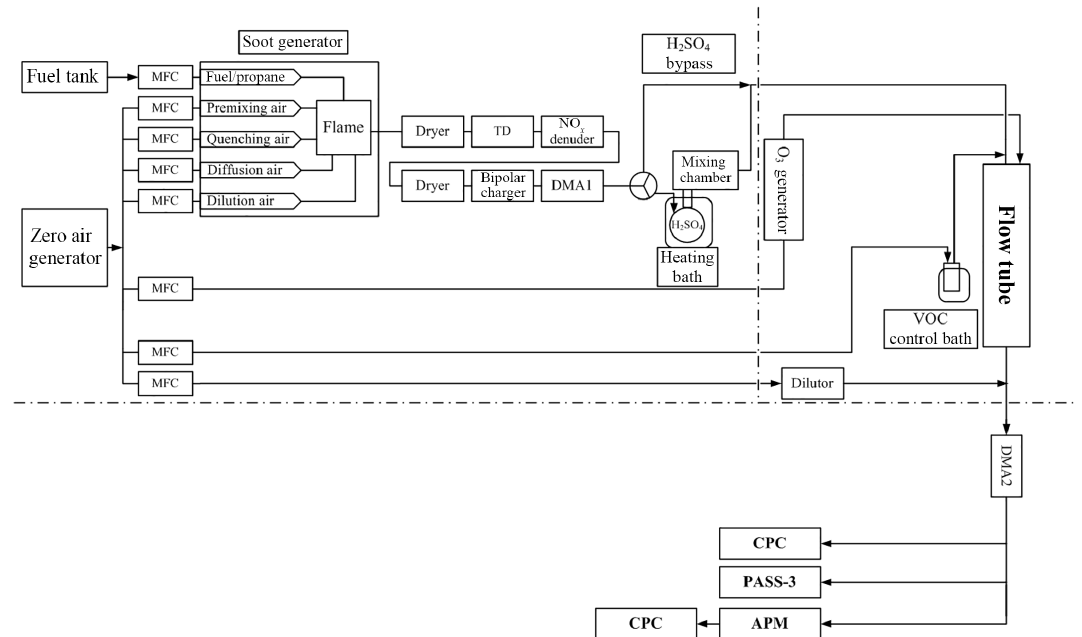
Figure 1. Schematic of the experimental setup. The flow rate of each gas line is regulated by a mass flow controller (MFC). The results of photo-acoustic soot spectrometry with three wavelengths (PASS-3) are not reported in this